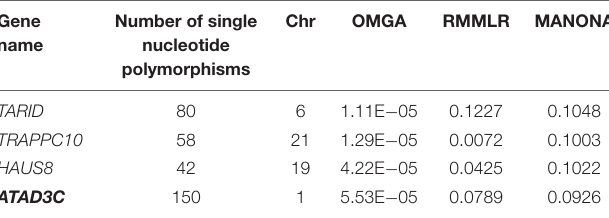
TABLE 2 | List of top genes and the p -values with different methods in the Human Liver Cohort study.